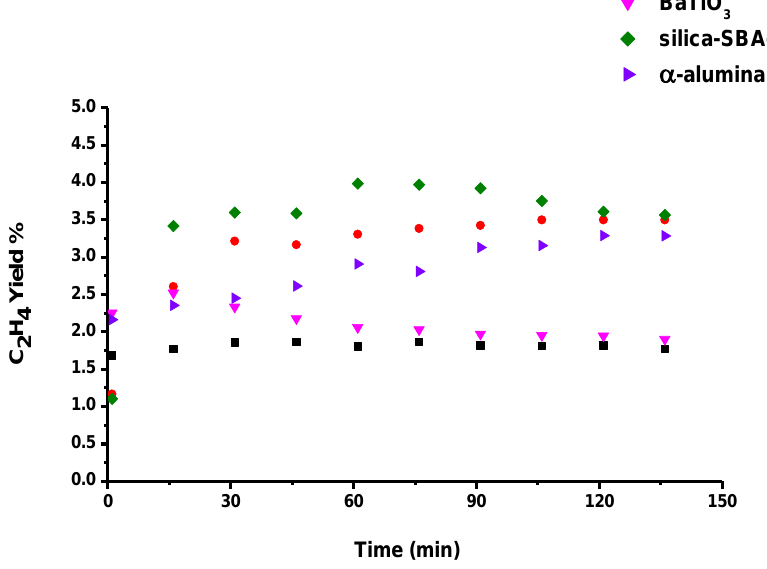
Figure 7. Yield of C 2 H 4 as a function of time for different packing materials.